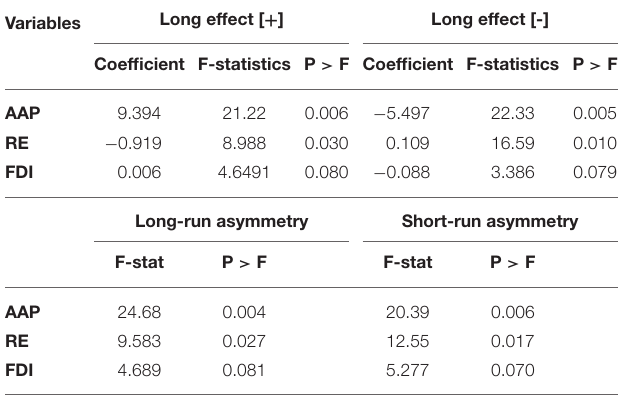
TABLE 5 | Granger causality